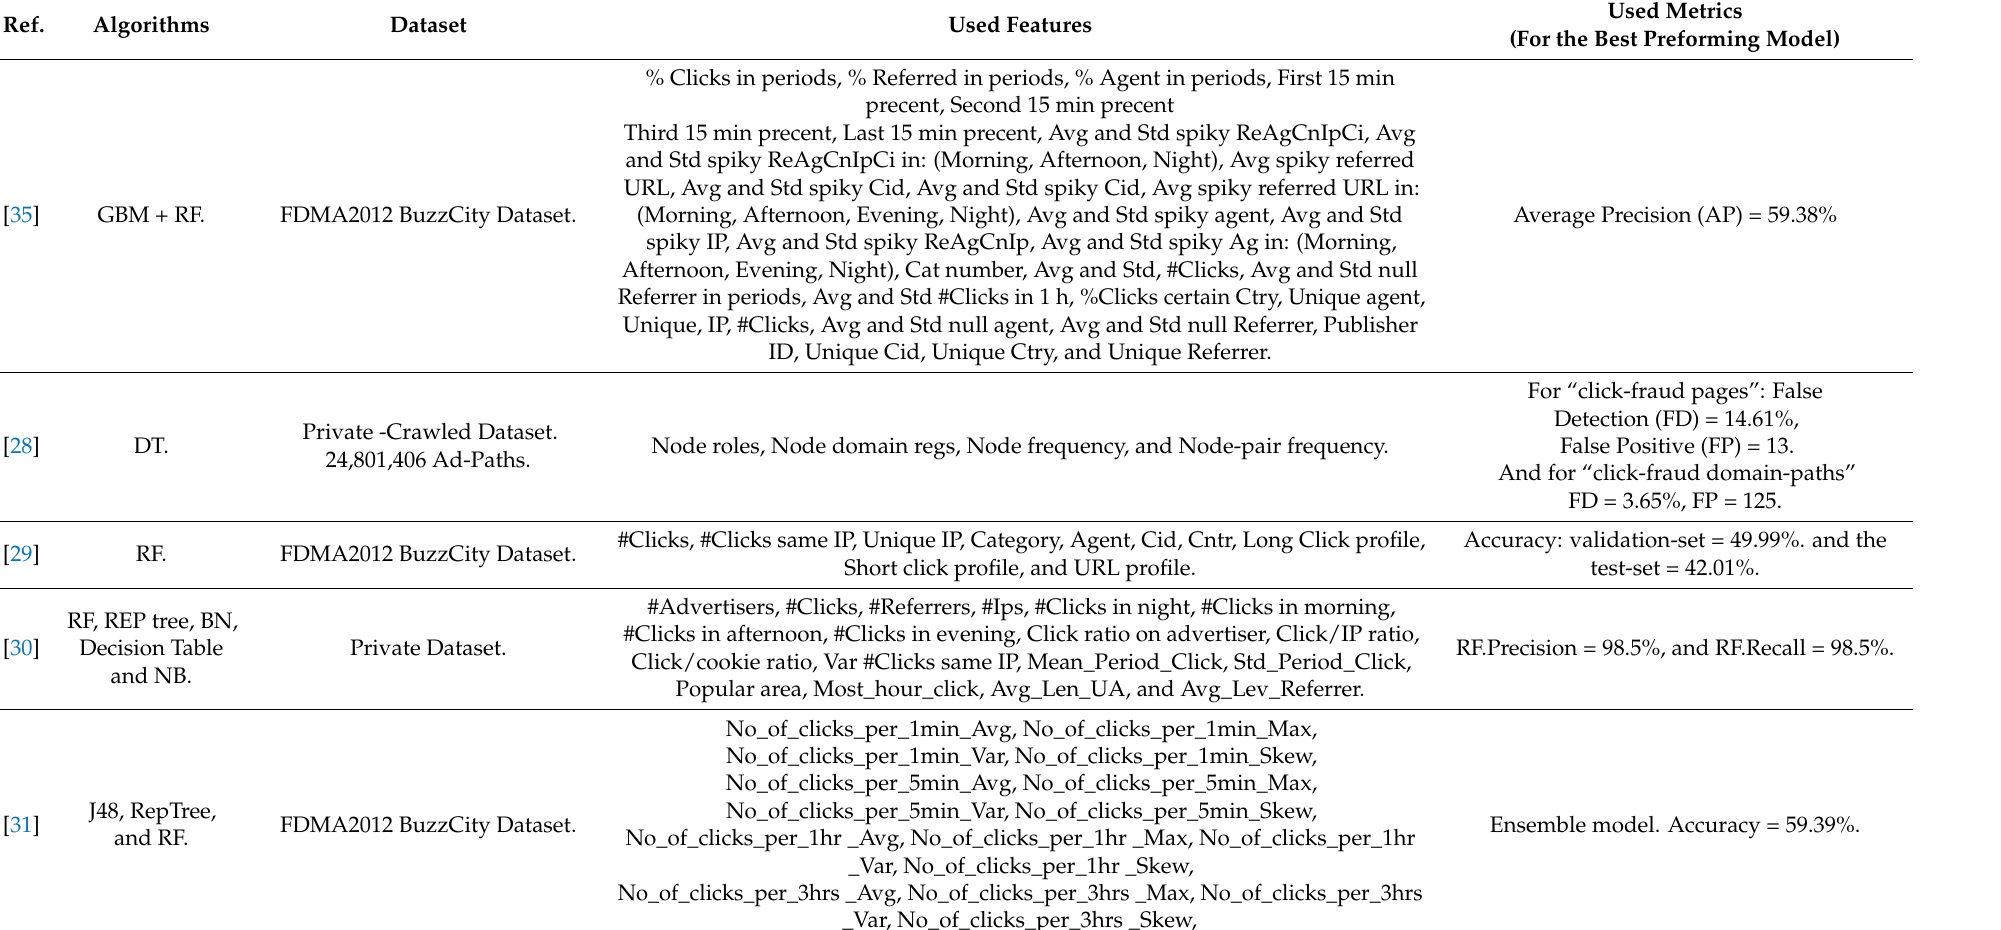
Table A1. Literature review summery table. Note: Studies are listed in chronological order